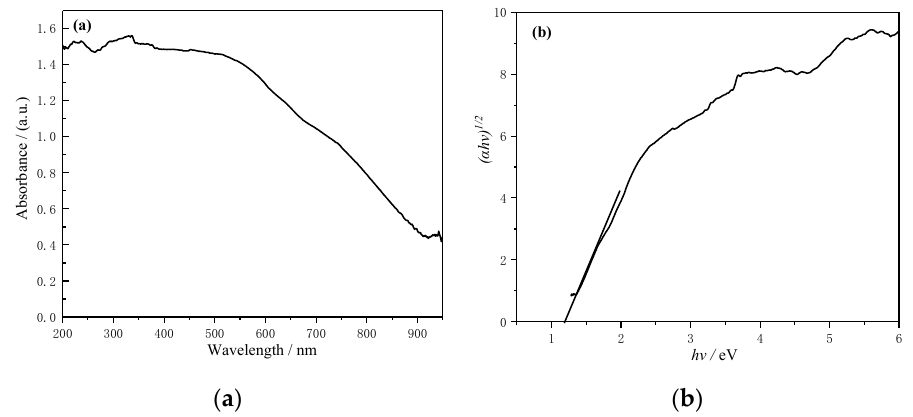
Figure 11. ( a ) UV–VIS absorption spectra of the YMn 2 O 5 sample, ( b ) Tauc–Mott plot of ( α h ν ) 1/2 versus h ν .